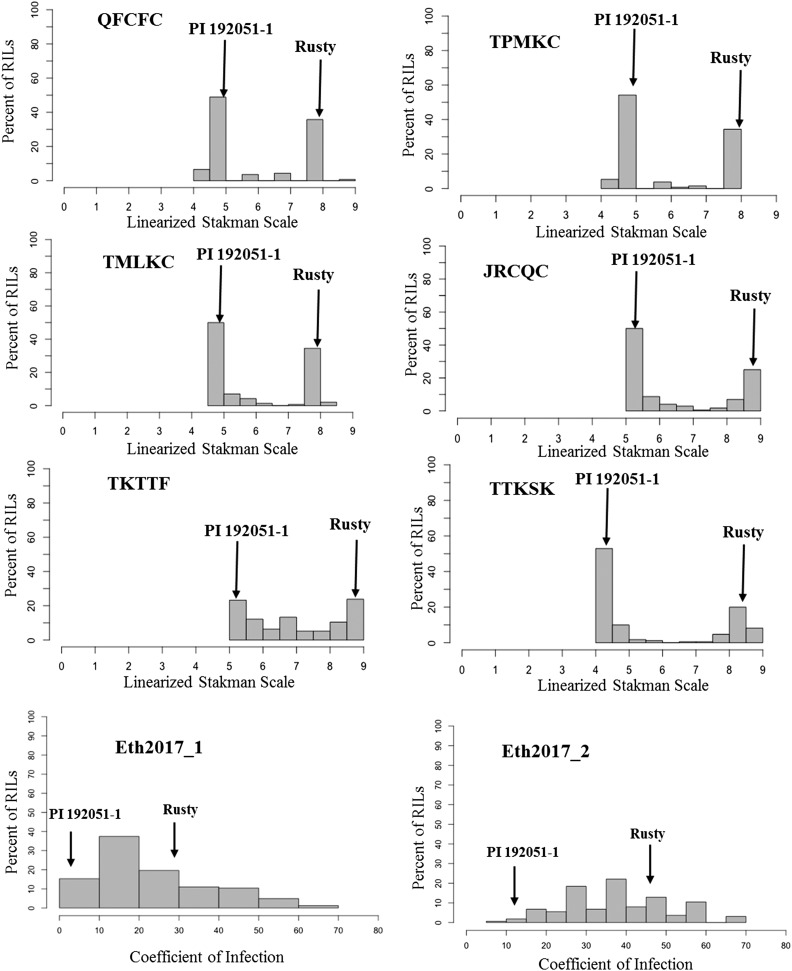
Distributions of the seedling data to Puccinia graminis f. sp. tritici races QFCFC, TPMKC, TMLKC, JRCQC, TKTTF, and TTKSK and field data in Ethiopia 2017 at two scoring dates (2017-1 and 2017-2) for recombinant inbred lines (RILs) of the cross Rusty × PI 192051-1. Median phenotypes for PI 192051-1 and Rusty are indicated on the graph. X- axes correspond to linearized Stakman scale (0 – 9) for the seedling data and coefficient of infection for the adult plant stage data.